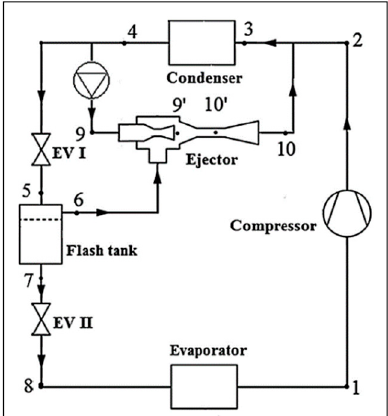
Figure 15. Schematic diagram of ejector-sub-cooled EERC [182].